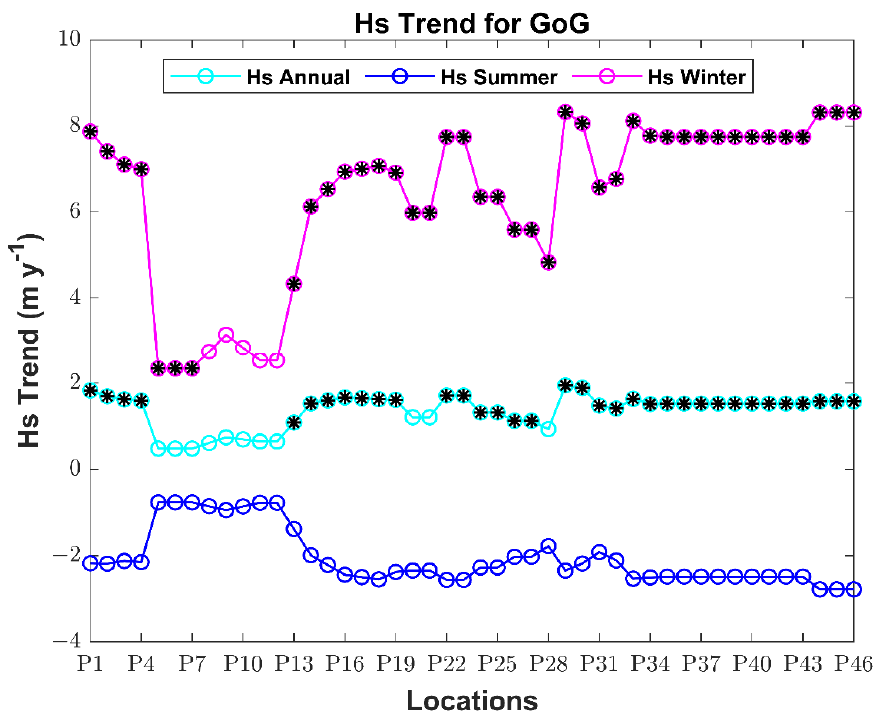
Figure 3. Line plot of the annual, winter and summer trends of Hs with asterisk showing locations with significant trend. Asterisk (*) represents significant Hs trend.